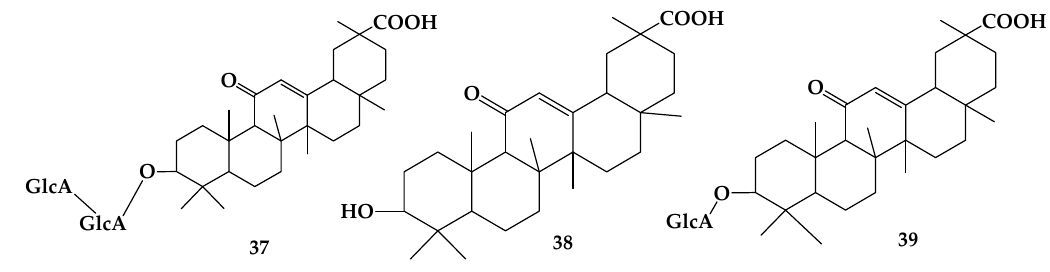
Figure 8. The chemical structures of compound 37–39